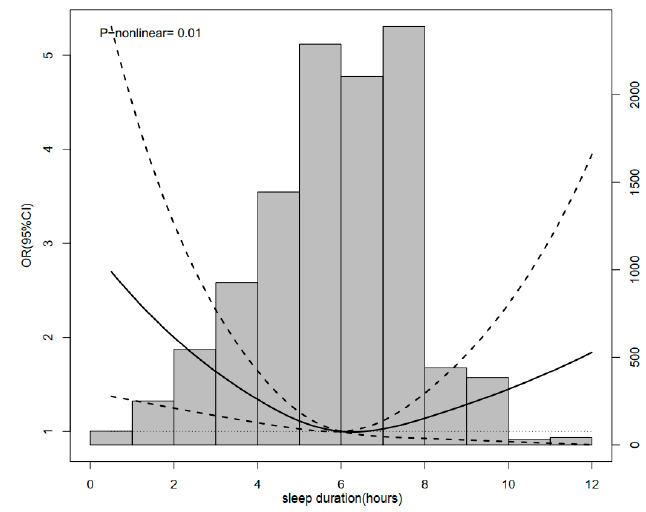
Figure 2. Restrictive cubic spline diagram between sleep duration and hip fracture.